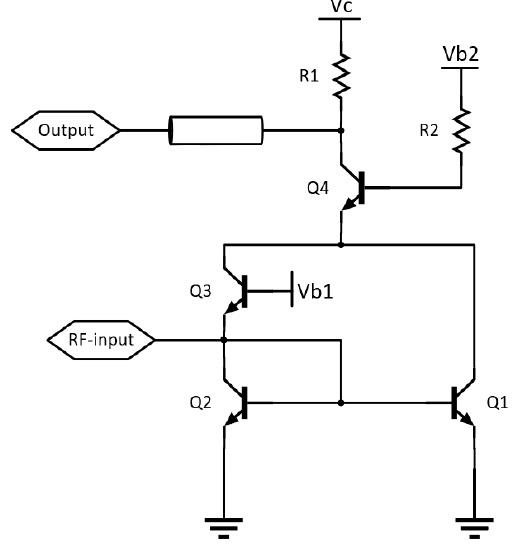
Figure 8. A schematic of the power detector.